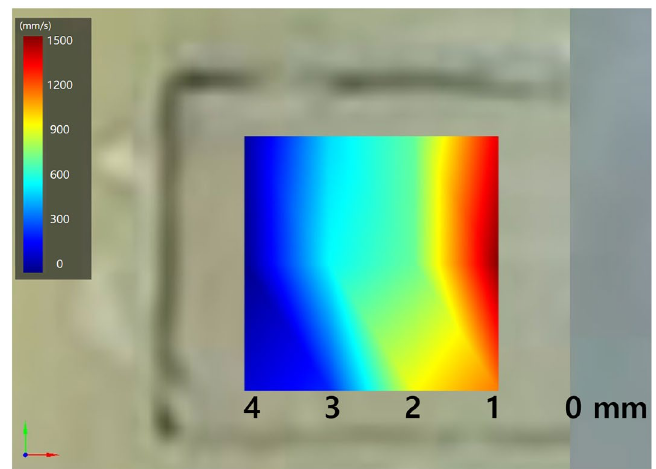
Figure 4. Representative colour map of composite resin vibration.